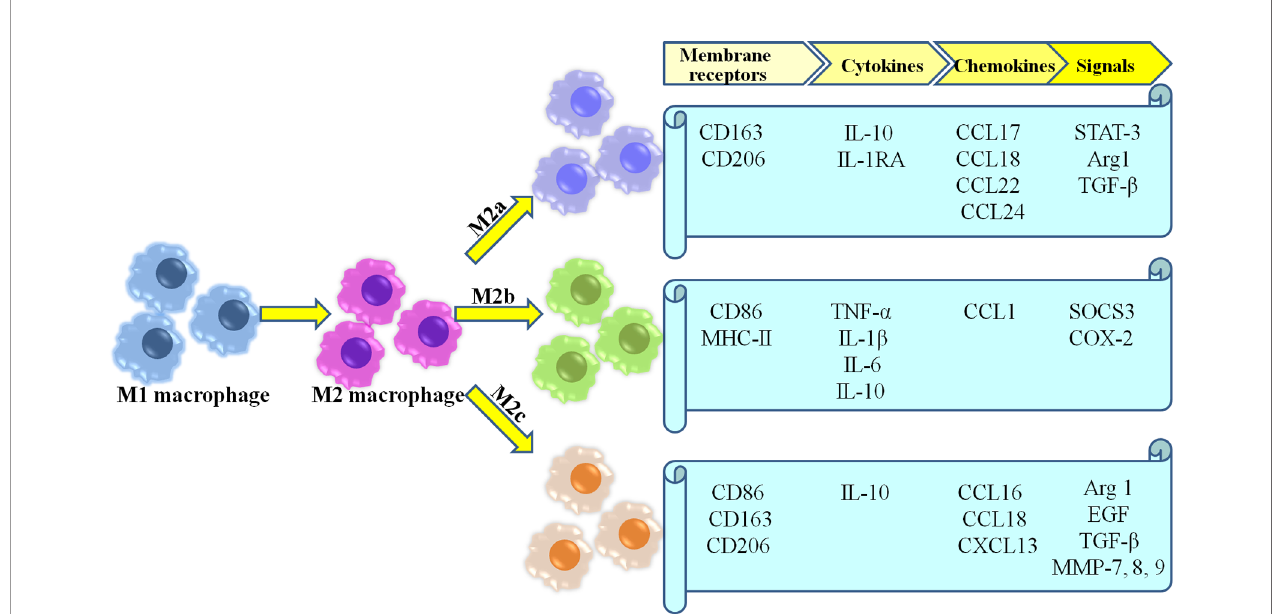
FIGURE 1 | Most common characteristics of M2 macrophages